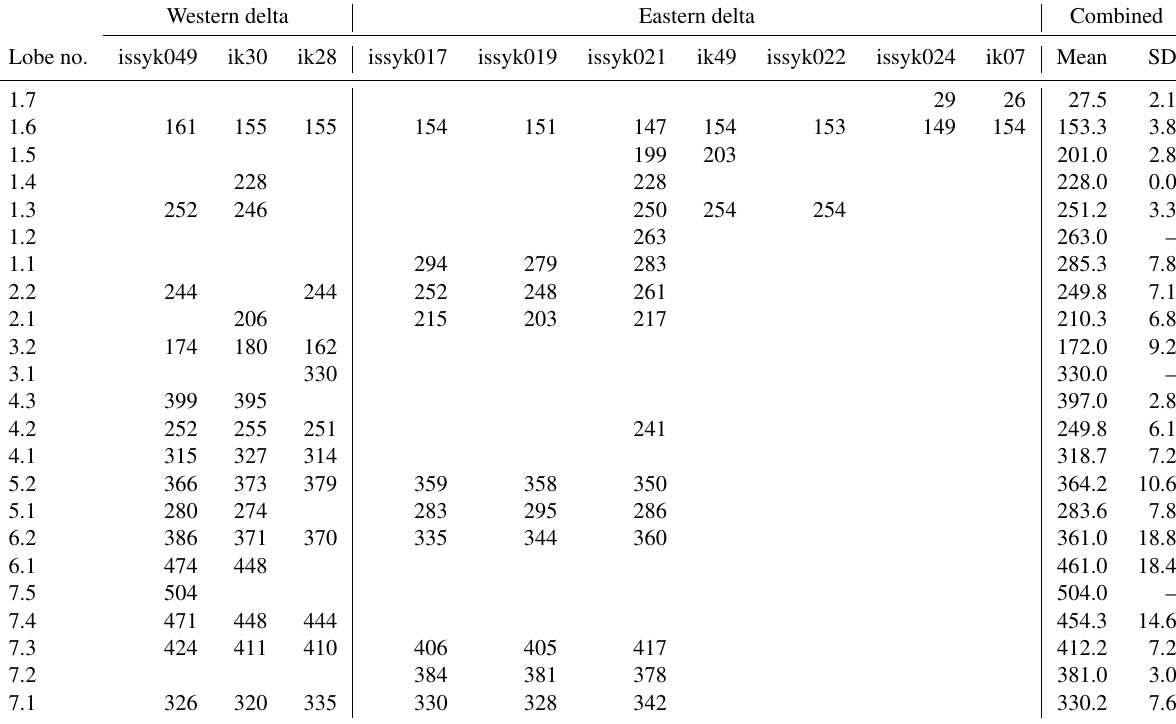
Table 1. Water depth below current lake level for each identified delta. Profiles issyk0049, ik30, and ik28 are located on the western delta and all other profiles are located on the eastern delta. Two-way travel time was converted to water depth using a sound velocity of 1500ms − 1 . Mean = average value. SD = standard deviation calculated for each delta lobe including measurements from the eastern and western areas where available. Western delta Eastern delta Combined Lobe no. issyk049 ik30 ik28 issyk017